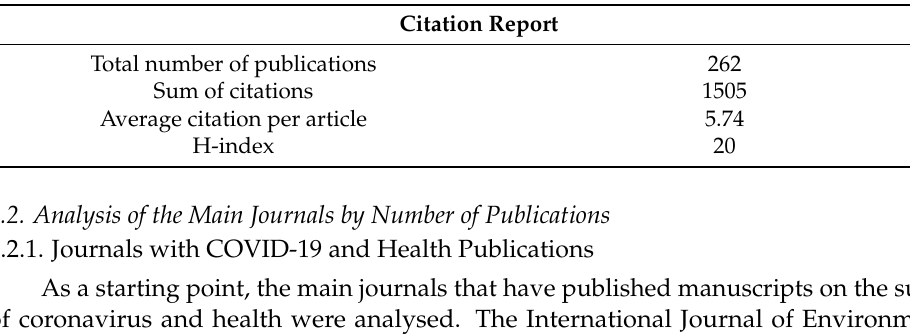
Table 2. Citation report (COVID-19/‘Health